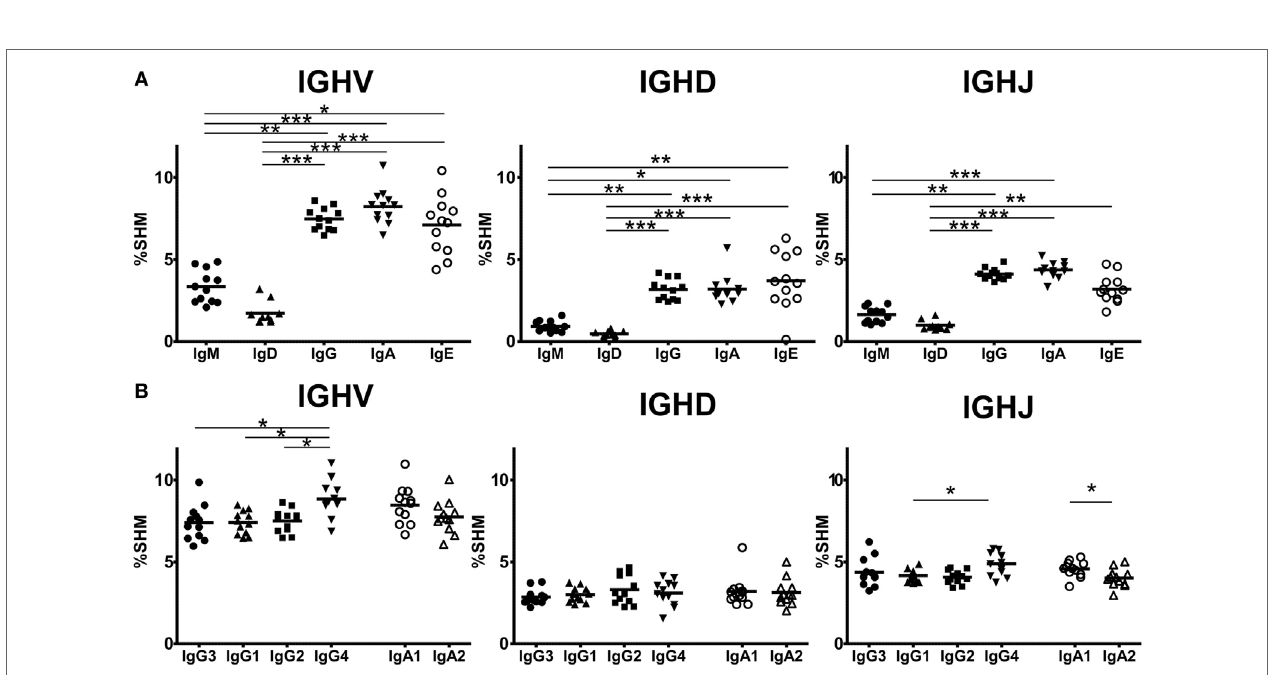
FigUre 5 | somatic hypermutation (shM) levels in immunoglobulin isotypes and subclasses . Frequencies of SHM in isotypes (a) and IgG and IgA subclasses (B) are shown. Frequencies of SHM in variable region (IGHV), diversity region (IGHD), and joining region (IGHJ) were calculated by comparison of sequence reads with the reference sequence. Sequence data from in-frame IgM (1,338,009 reads), IgD (1,279,881), IgG3 (60,000), IgG1 (503,101), IgG2 (667,076), IgG4 (19,708), IgA1 (866,180), IgA2 (519,390), and IgE (87,474 reads) were used to calculate SHM. For IGHV and IGHD, the SHM levels of IgG, IgA, and IgE were significantly higher than those of IgM and IgD. Similarly, for IGHJ, the SHM levels of IgG and IgA were significantly higher than those of IgM and IgD and the SM levels of IgE were significantly higher than those of IgD. Regarding IgG and IgA subclasses, IgG4 had significantly higher SHM levels in IGHV regions than IgG3, IgG1, and IgG2 ( P < 0.05). The SHM levels of IgG4 were significantly higher than those of IgG1. On the other hand, there were no significant differences in the SHM levels in both IGHV and IGHD between IgA1 and IgA2, but the SHM levels of IgA2 was significantly lower than those of IgA1. Significance: * P < 0.05, ** P < 0.01, and *** P < 0.001.